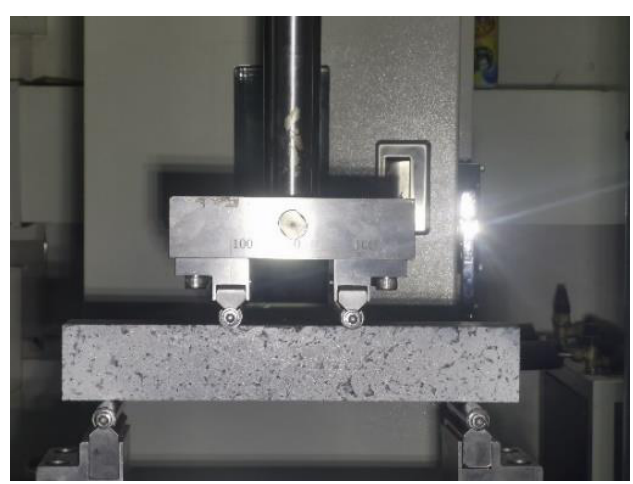
Figure 3. Loading waveform curve.